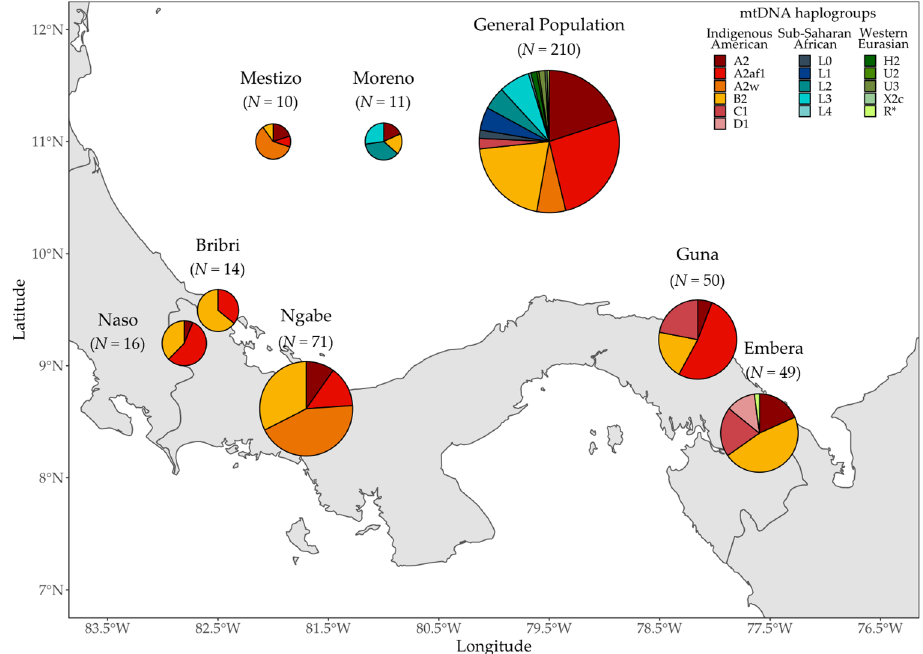
Figure 1. Map showing the haplogroup distribution of the 431 mtDNAs according to the self- reported affiliation of the participants in the study. Location of Indigenous groups corresponds to their specific Indigenous Comarca (Naso Tjër Di, Ngäbe, Guna, and Emberá). As for the Bribri, most of them live within Costa Rican borders, and about 3000 are settled in Panama. The size of each pie chart is proportional to the number of individuals from each group. Haplogroup origins are indicated by shades of different colors. Diereses and accents were not considered when labeling the different groups.